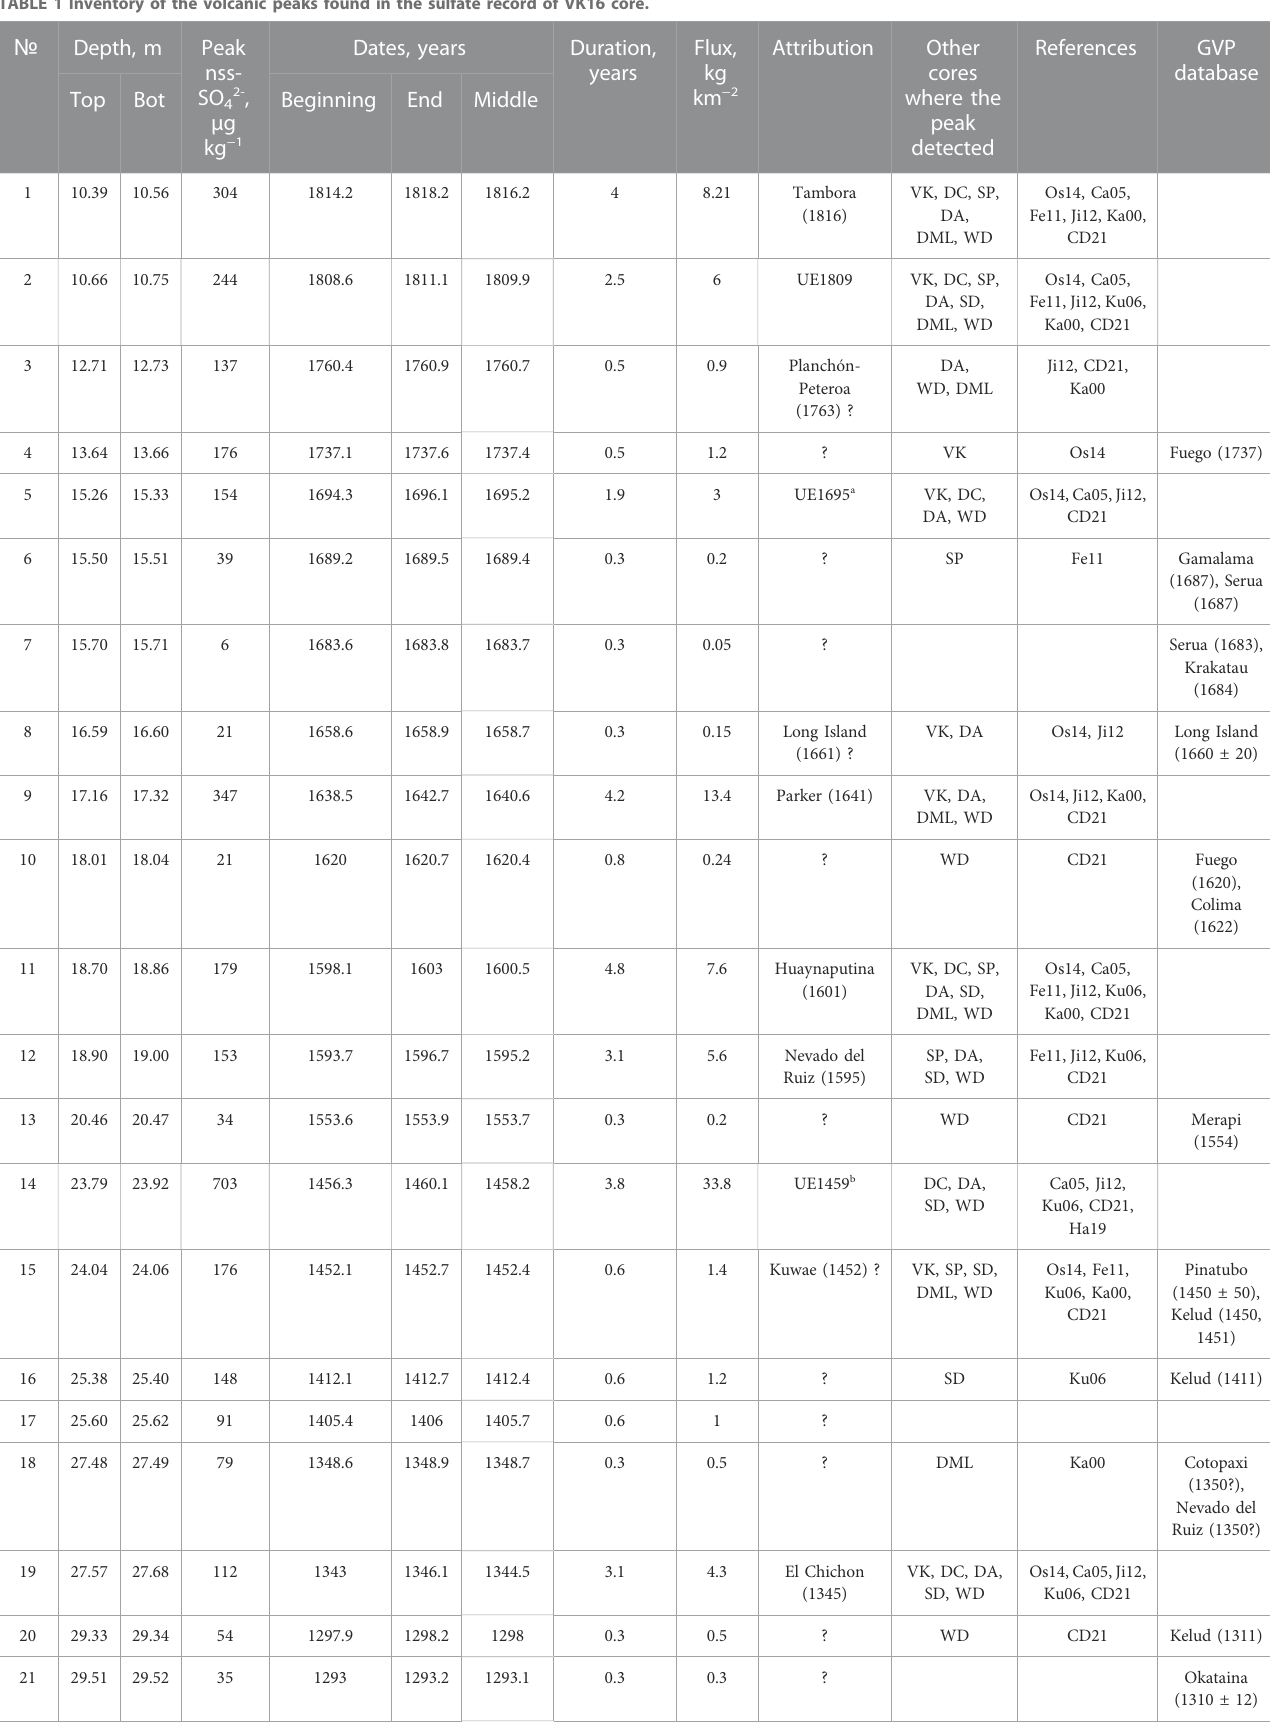
TABLE 1 Inventory of the volcanic peaks found in the sulfate record of VK16 core. № Depth,